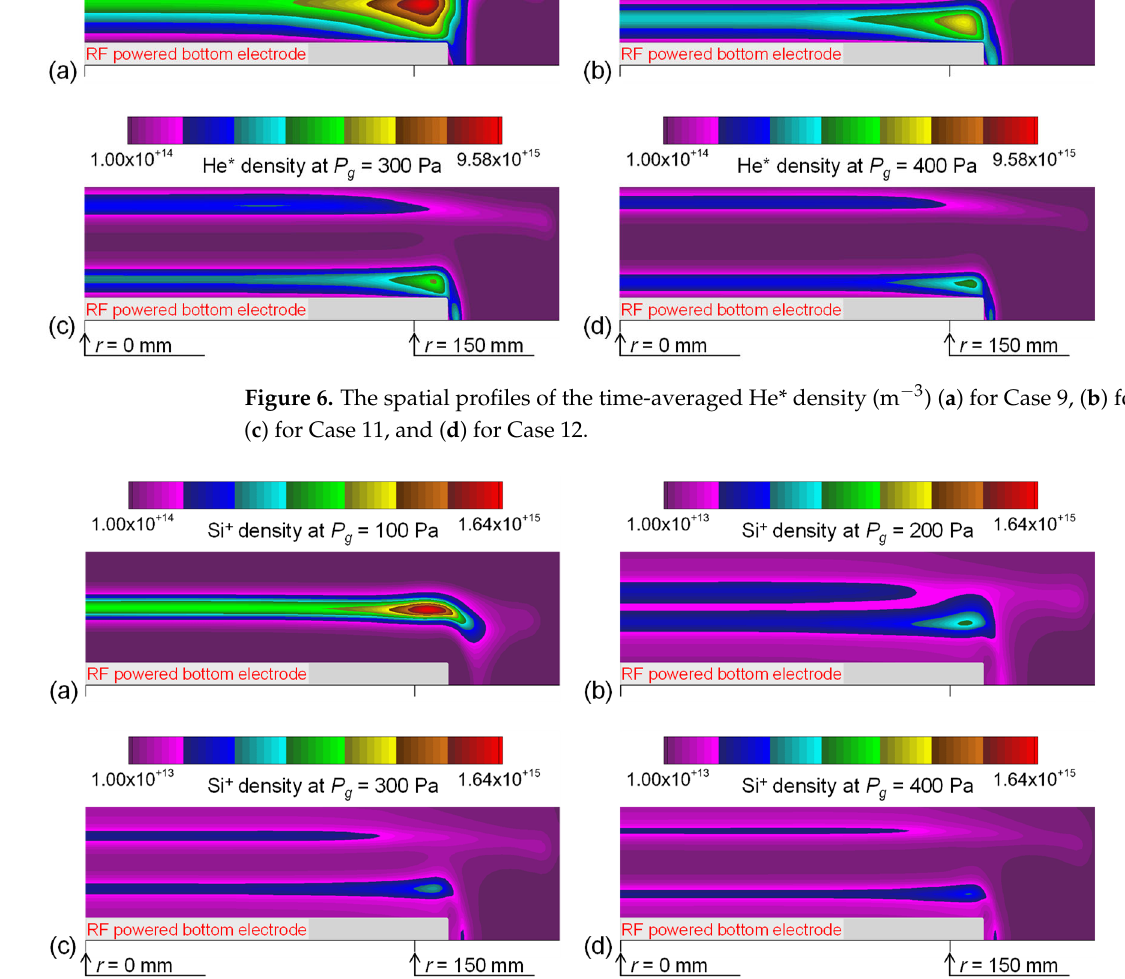
Figure 7. The spatial profiles of the time ‐ averaged Si + density (m − 3 ) ( a ) for Case 9, ( b ) for Case 10, ( c ) for Case 11, and ( d ) for Case 12.